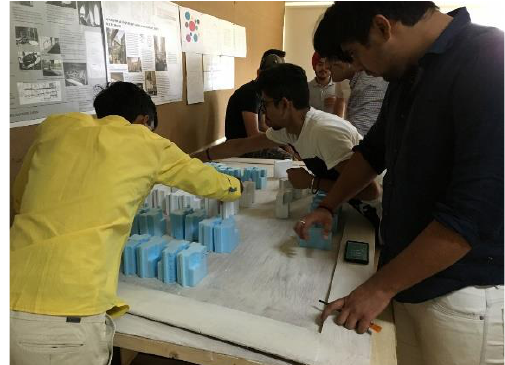
Figure 7. We encouraged and taught the students to make a solid base that accommodates for individual models. We brought new materials to the supply store and described and encouraged new ways of working. Photo